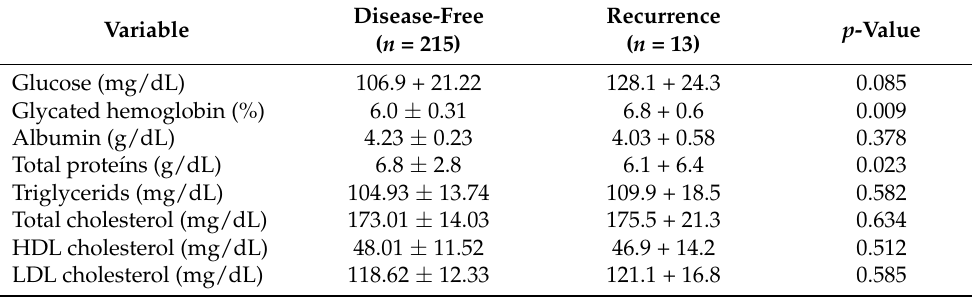
Table 4. Preoperative nutritional, glycemic, and lipid profile.